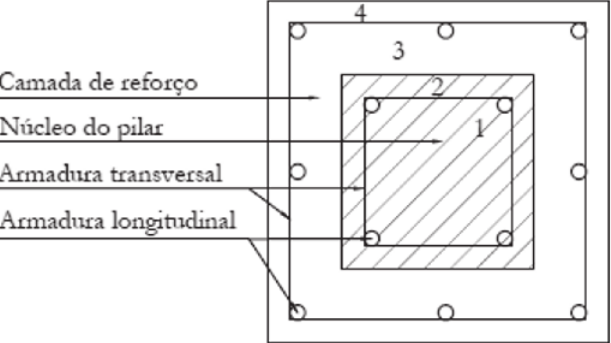
Esquema da seção transversal do pilar reforçado por encamisamento com concreto dos. A resistência do pilar reforçado foi determinada por meio da adição da resistência das armaduras longitudinais com a resistência